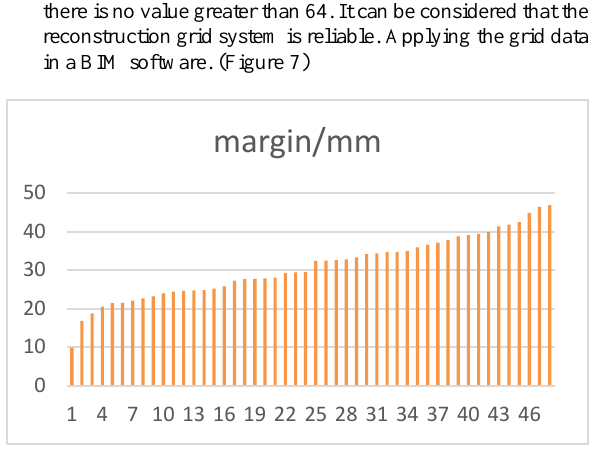
Table 1. the grid data of Jingfu palace